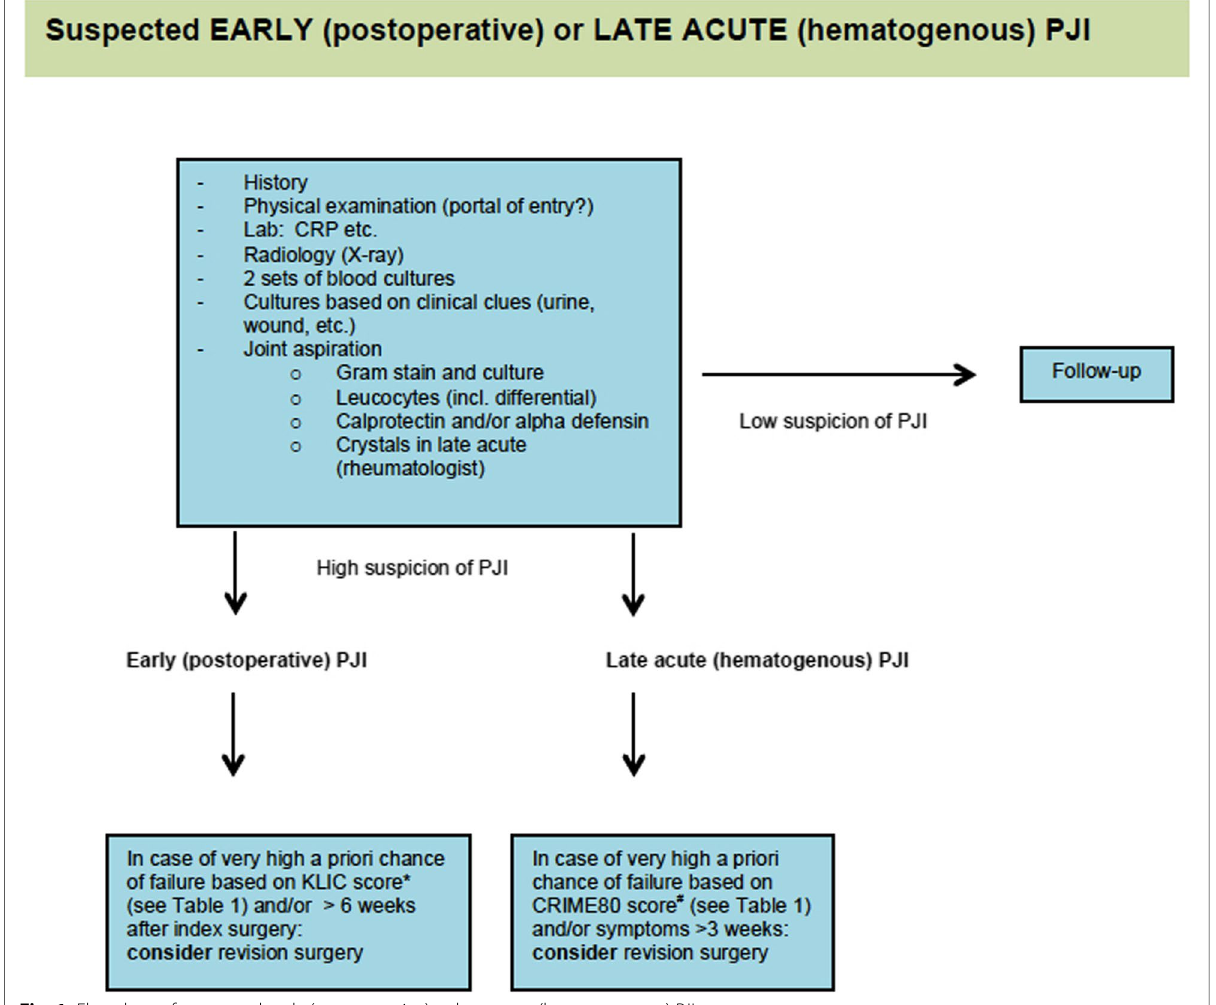
Fig. 1 Flowchart of suspected early (postoperative) or late acute (hematogenous) PJI. *KLIC: Kidney, Liver cirrhosis, Index surgery, C‑reactive protein and Cemented prosthesis (see Table 1) [7, 8]. # CRIME80: Chronic obstructive pulmonary disease, Rheumatoid arthritis, Index surgery, Male gender, Exchange of mobile components and age > 80 years (see Table 1)